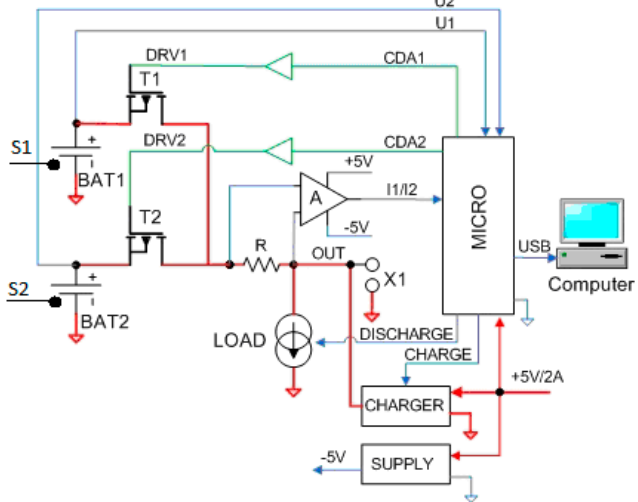
Figure 2. The SWD block schematic. BAT1, BAT2 = 18650 cells; S1, S2 = temperature sensors; T1, T2 = power switches, DRV1, DRV2 = gate drivers, R = current sensing resistor, A = differ- ential amplifier, LOAD = programmable constant current active load, MICRO = microcontroller, CHARGER = CC–CV